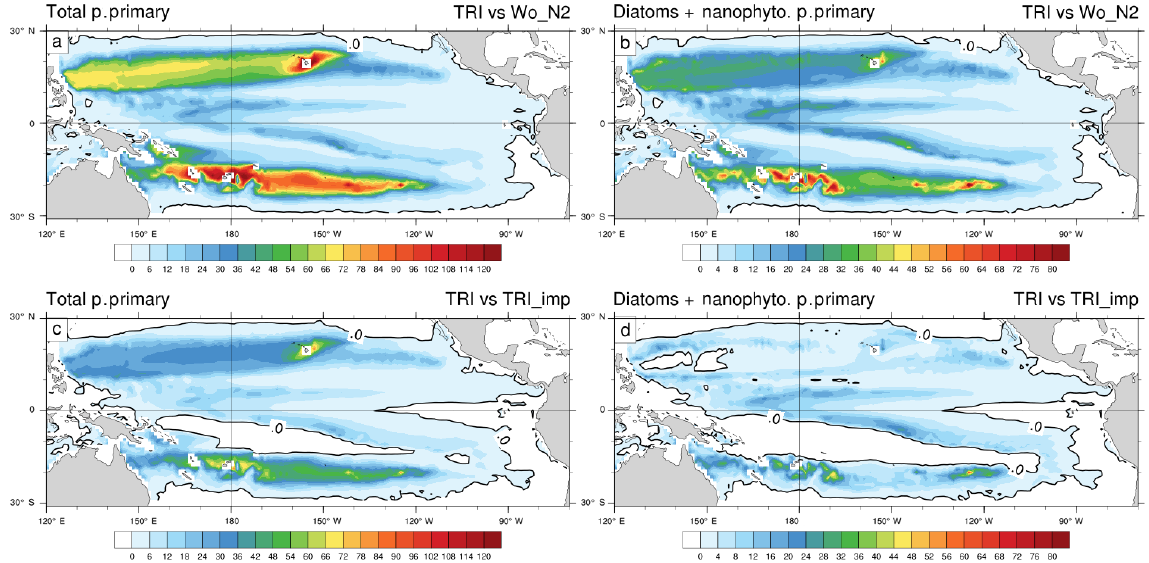
Figure 10. Percentage increase in primary production between the TRI simulation and the Wo_N2 simulation (a, b) and the TRI_imp simulation (c, d) ; panels (a) and (c) show total primary production including the contribution of Trichodesmium whereas in panels (b) and (d) , primary production only includes the contribution of diatoms and